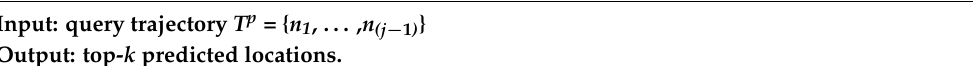
Algorithm 1. Location Prediction Algorithm.